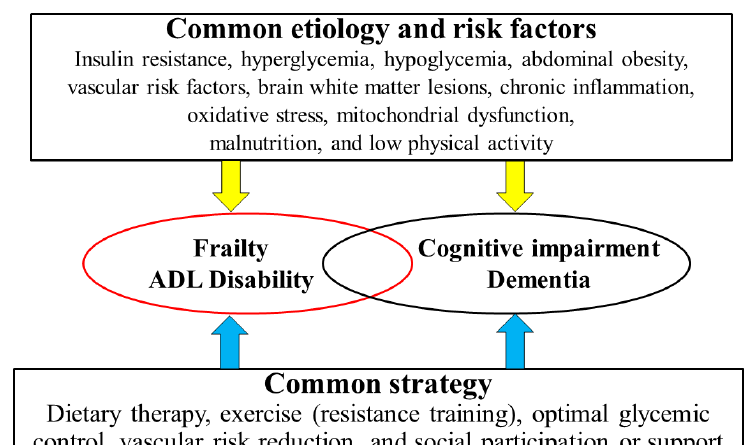
Figure 5. Common etiologies, risk factors, and strategies for frailty and cognitive impairment. Based on the common etiologies and risk factors shared between frailty and dementia, including insulin resistance, hyperglycemia, hypoglycemia, abdominal obesity, arteriosclerotic disease, cerebral white matter lesions, chronic inflammation, malnutrition, and low physical activity, common strategies such as dietary therapy, exercise, optimal glycemic control, treatment of arteriosclerotic risk factors, and social participation and support are important for e ff ective management. ADL, activities of daily